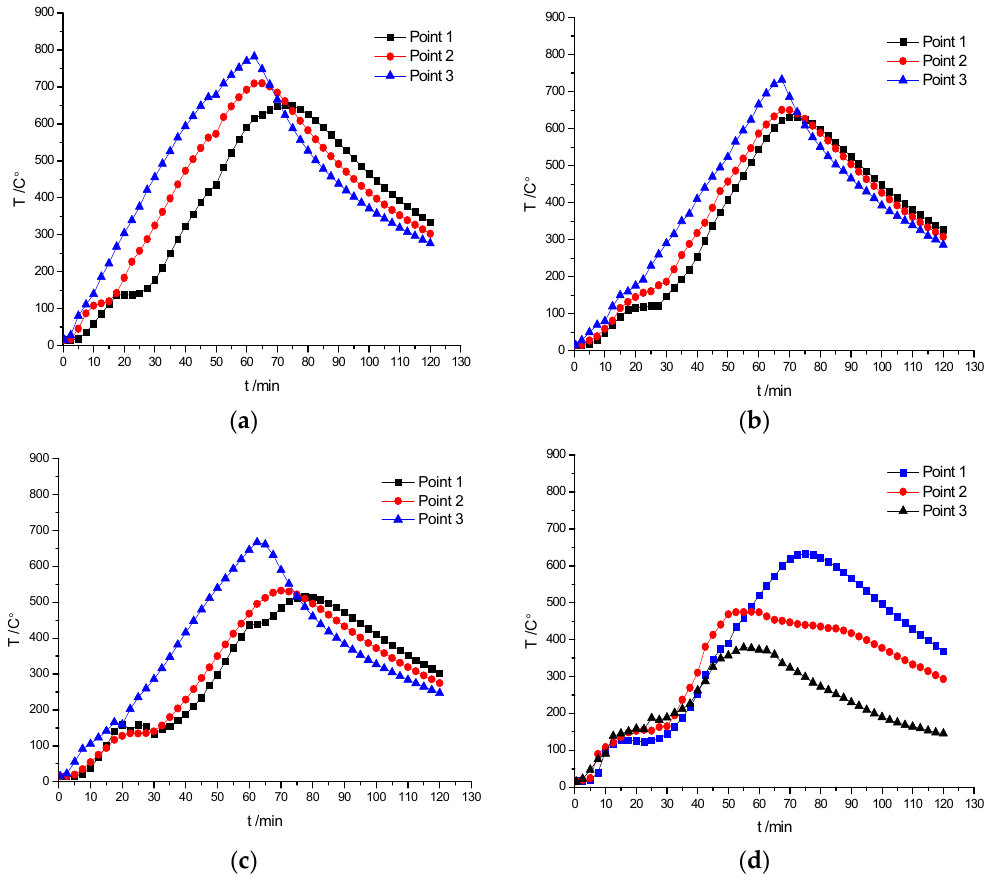
Figure 19. Temperature–time curve of specimens. ( a ) FC-N-T1; ( b ) FC-Ra-T1; ( c ) FC-Rb-T1; ( d ) FC-Rb-T2.